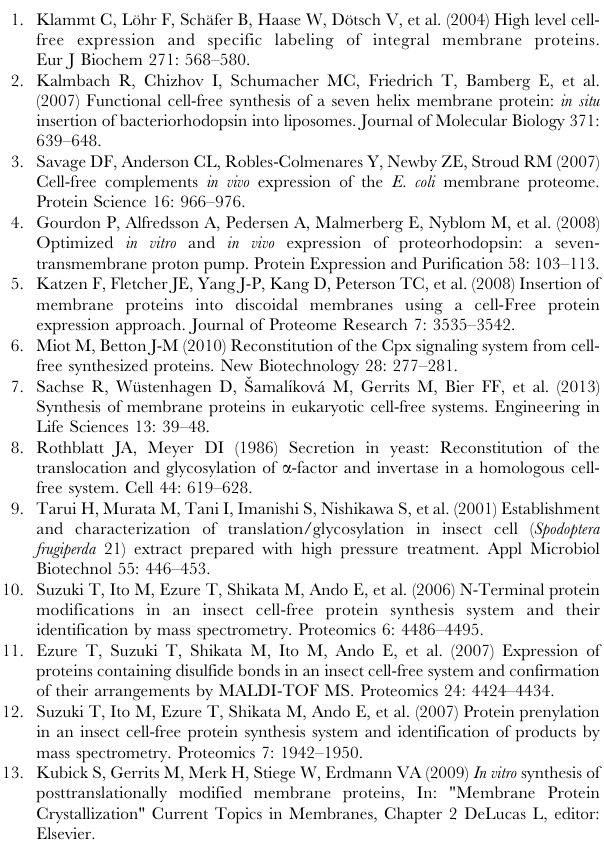
Table S1 List of cell-free expressed model